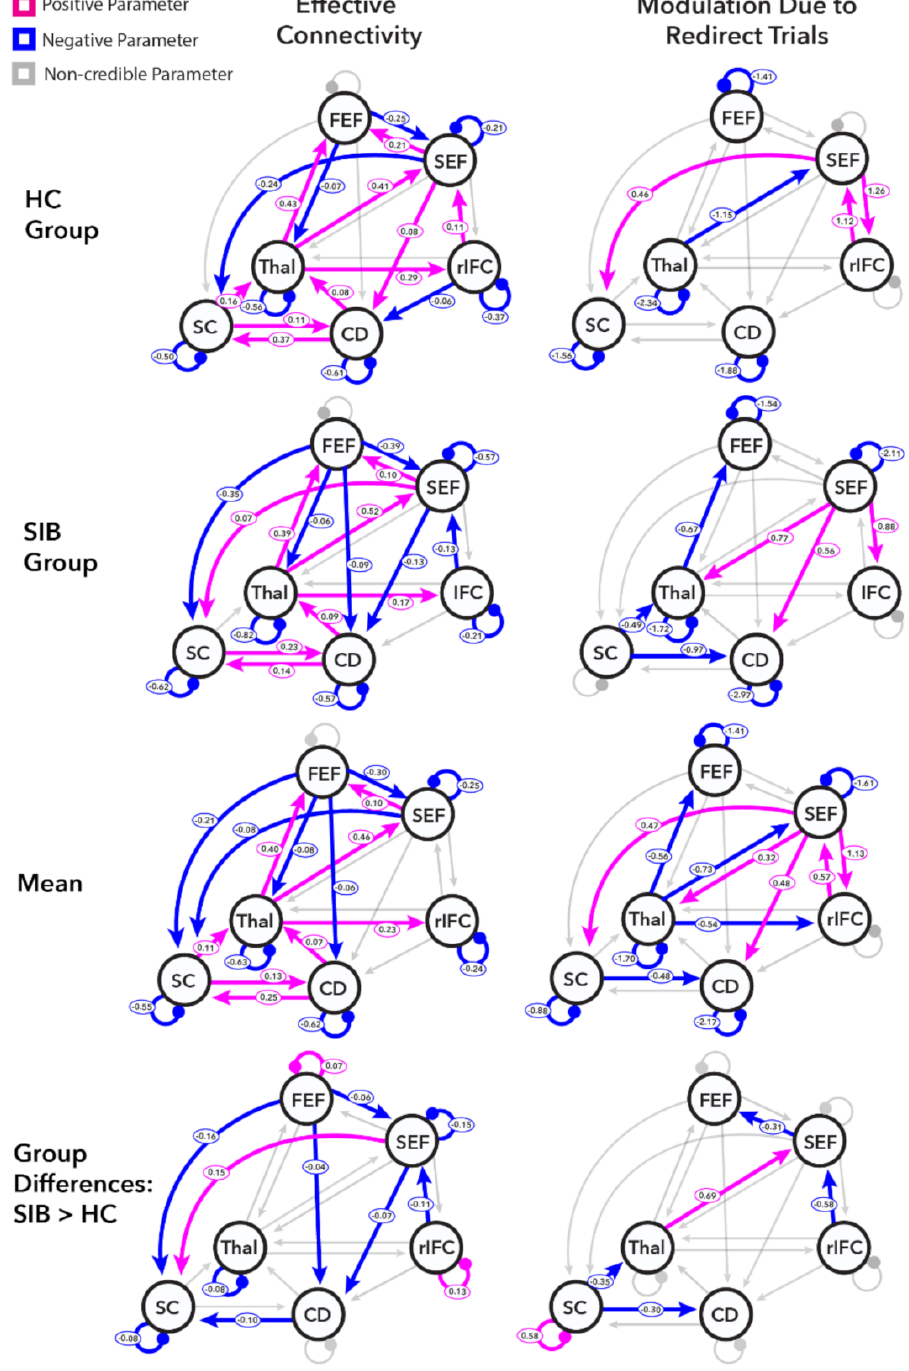
Figure 6. Results of the dynamic causal modeling (DCM) representing separate parametric empirical Bayesian analyses and the Bayesian model comparison for HC and SIB, which are depicted in the top two rows, respectively. The bottom two rows depict the group data. The left column (effective connectivity) depicts the mean effects throughout the task, whereas the right column (modulation due to redirect trials) refers to parameters that additively modulate the mean connectivity on redirect trials. The mean row depicts the group average effective connectivity and modulation in the redirect trials across both groups. The group differences row depicts the connections with credible between- group differences. The credible parameters were those with a posterior probability of differing from zero greater than 95%. SEF: supplementary eye fields (bilateral); FEF: frontal eye fields (bilateral); rIFC: right interior frontal cortex; Thal: thalamus; CD: caudate; SC: superior